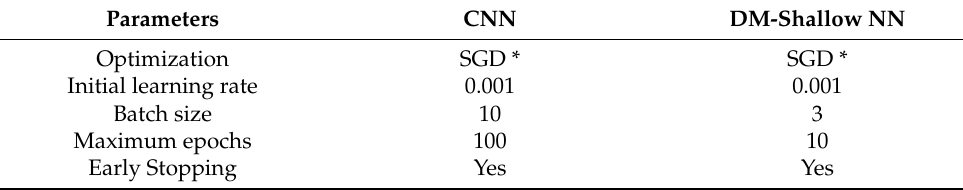
Table 3. Hyperparameters for the VGG16 CNNs and the Shallow NNs. Parameters CNN DM-Shallow NN Optimization SGD * SGD * Initial learning rate 0.001 0.001 Batch size Maximum epochs Early Stopping